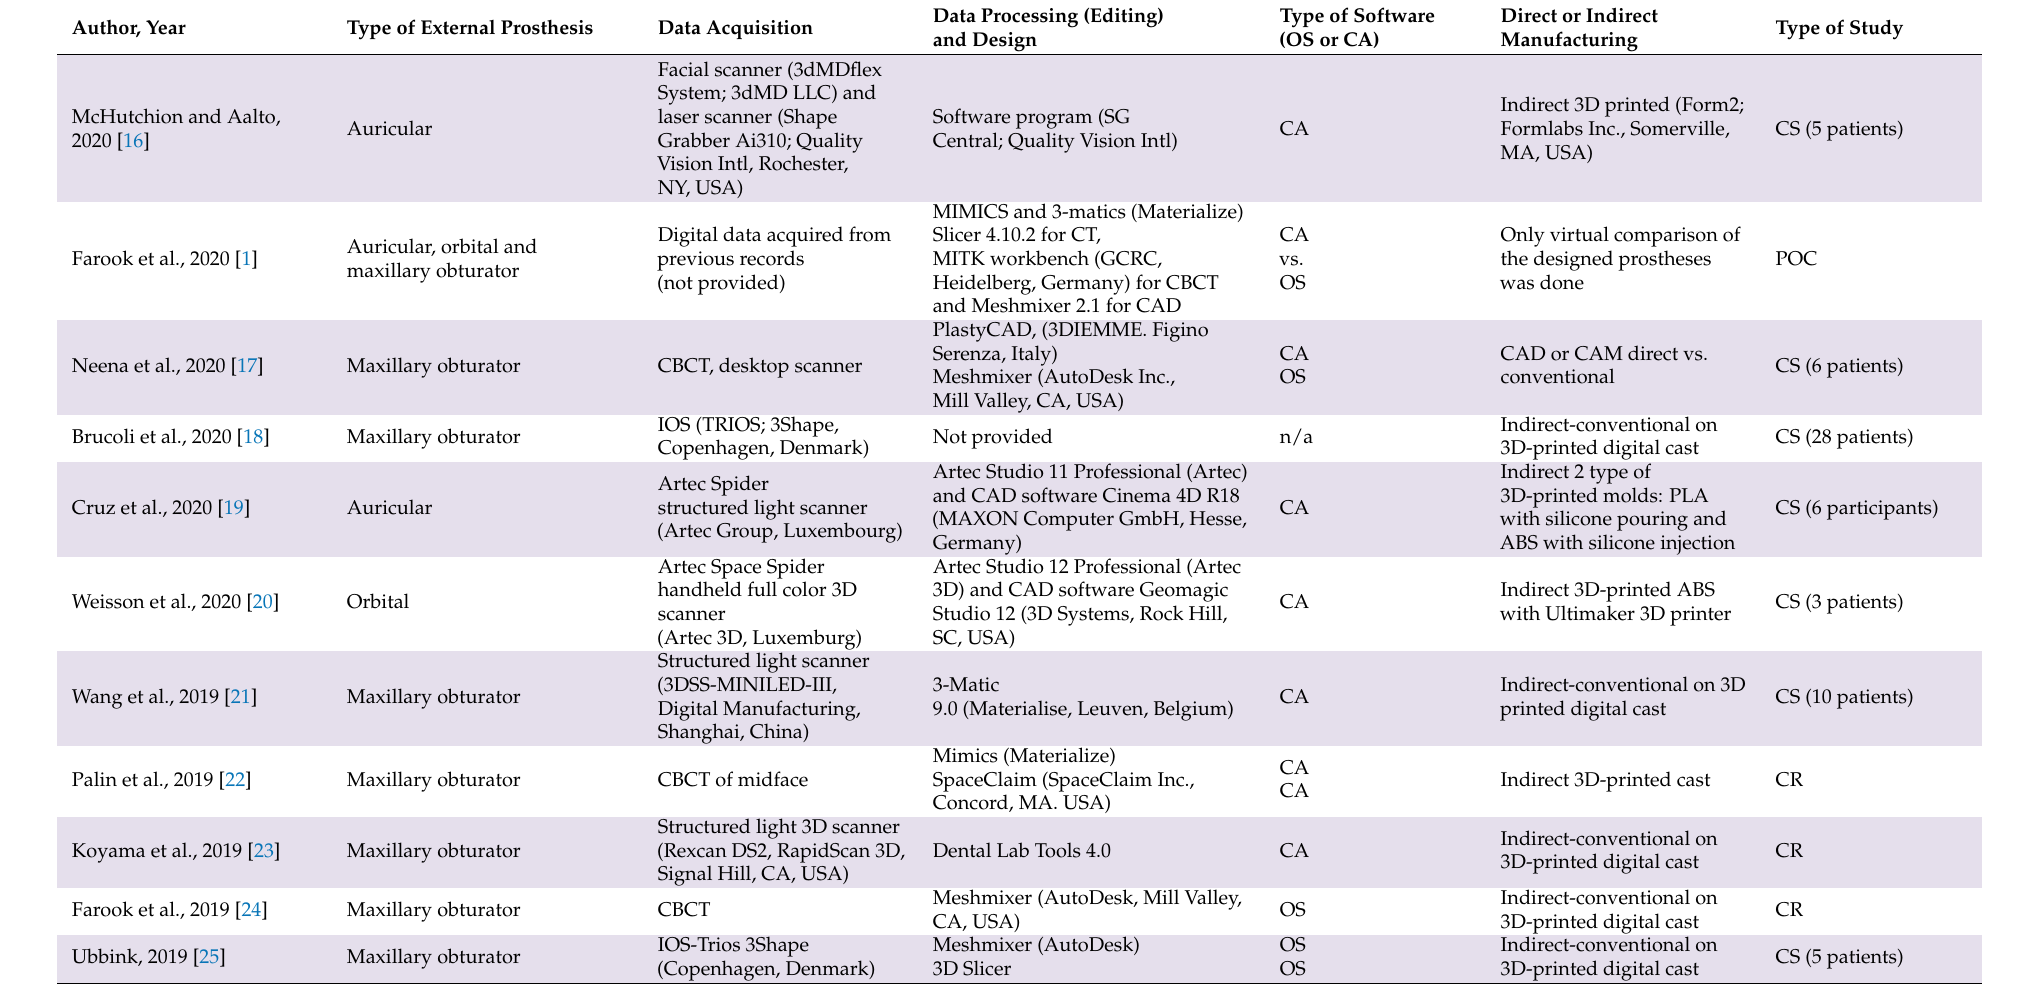
Table 1. Data acquisition, editing, design and manufacturing of maxillofacial